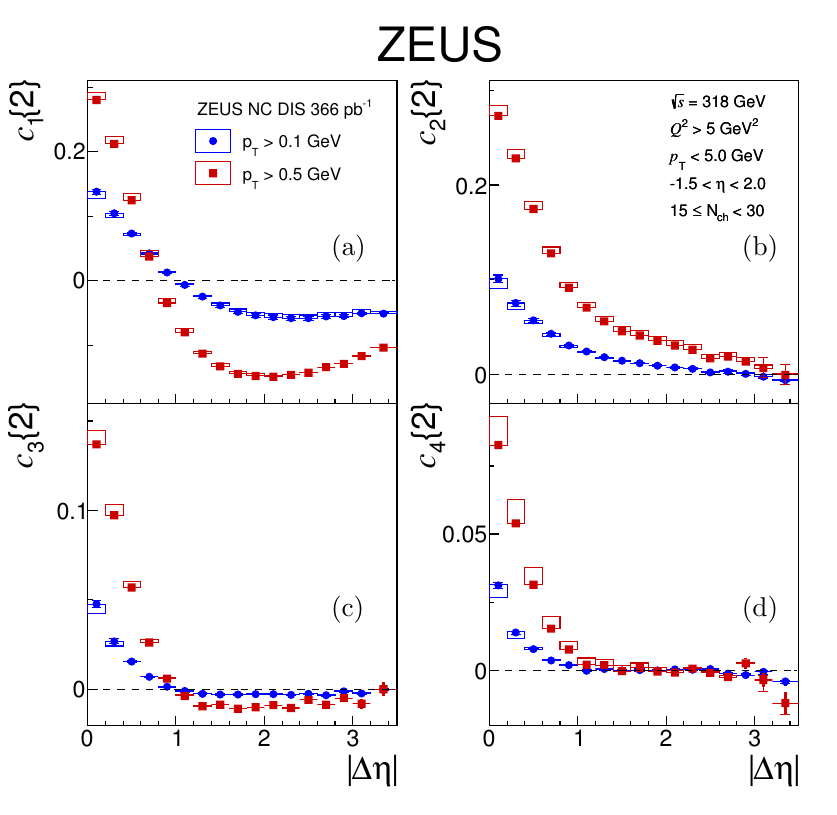
Figure 8 . Correlations c n f 2 g for 15 (cid:20) N ch < 30 as a function of j (cid:1) (cid:17) j for (a) n = 1, (b) n = 2, (c) n = 3, (d) n = 4. Two selections of transverse momentum intervals are shown: p T > 0 : 1 GeV and